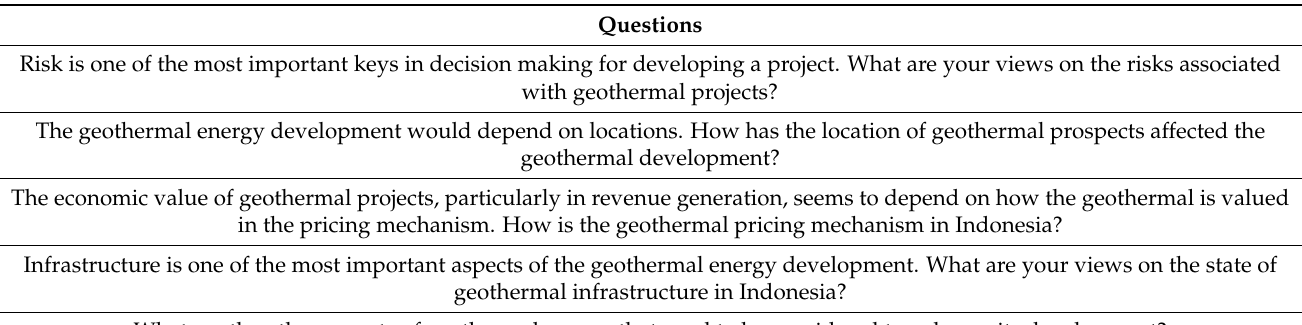
Table 2. Guiding questions for the